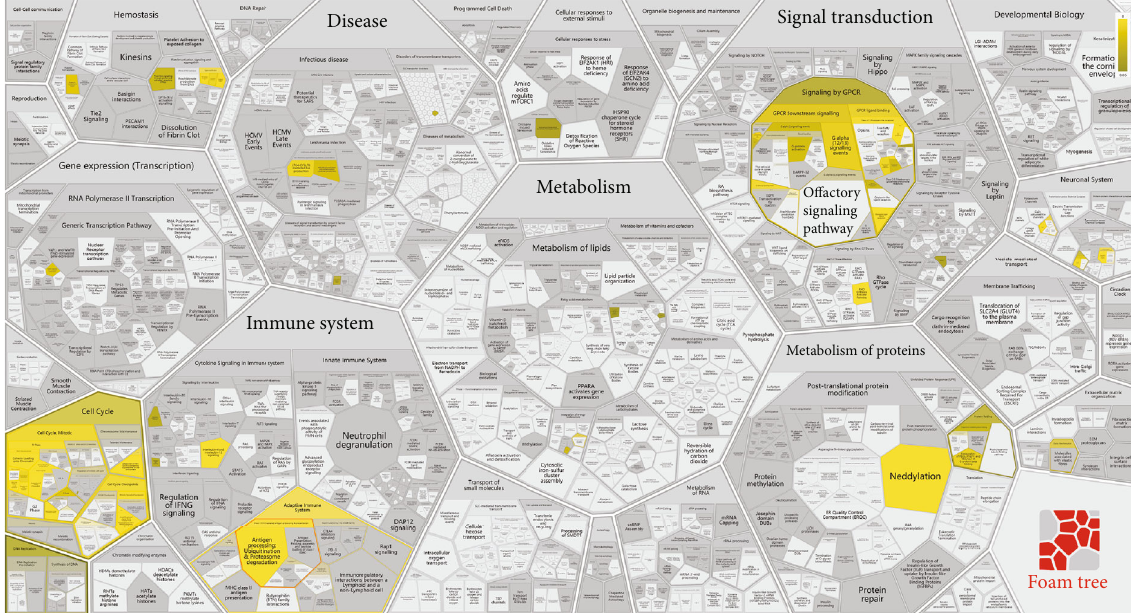
Figure 3: Reactome pathway enrichment of key module genes. The brighter the color, the more signi fi cant the pathway enrichment. The analyses were done using the Reactome pathway database. A Q value < 0.05 was considered statistically signi fi